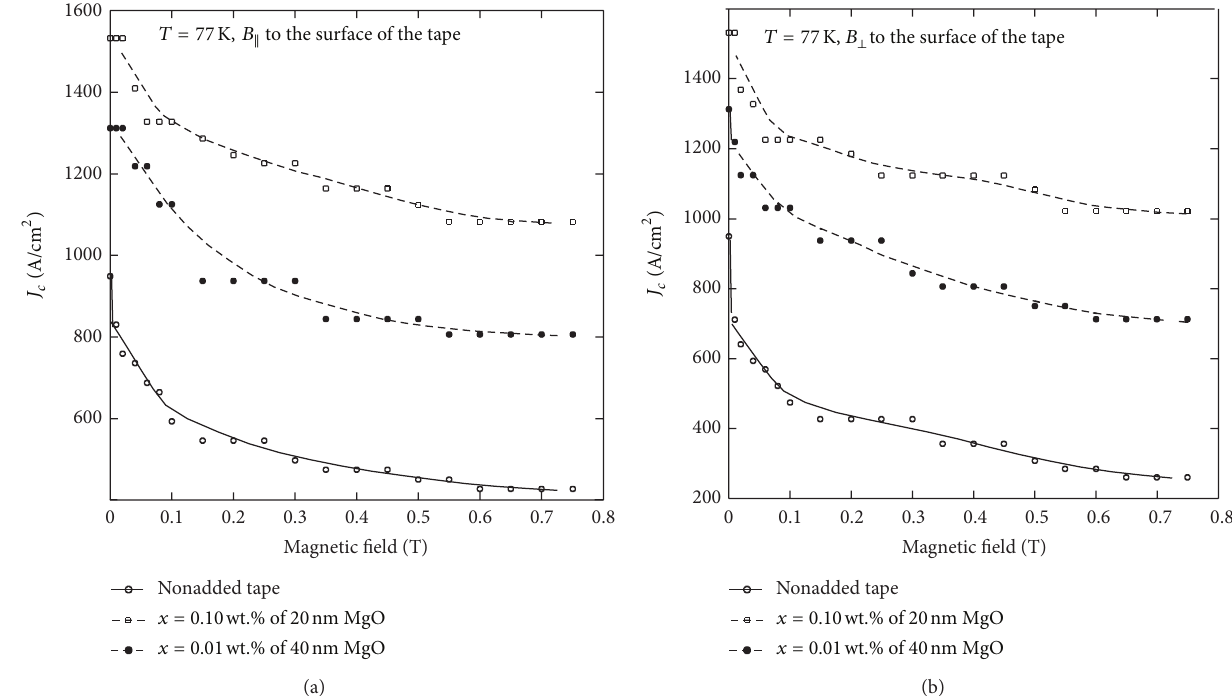
Figure 4: 𝐽 𝑐 of 𝑥 = 0 wt.%, 𝑥 = 0.10 wt.% of 20nm MgO, and 𝑥 = 0.01 wt.% of 40 nm MgO added tapes under magnetic field parallel 𝐵 ‖ and perpendicular 𝐵 ⊥ to the surface of the tape at 77